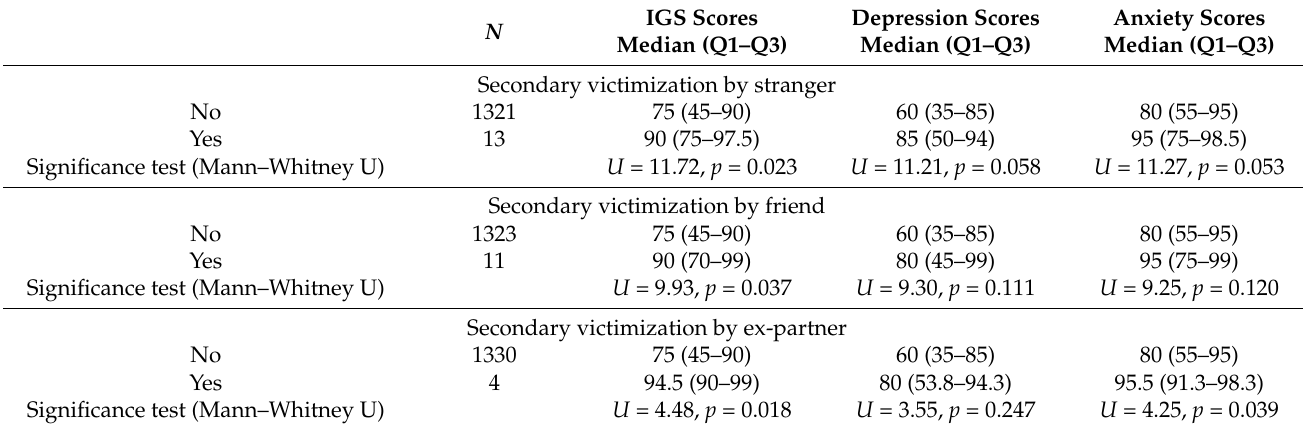
Table 3. Median and quartiles in parentheses for psychopathology scores and perpetrator of secondary